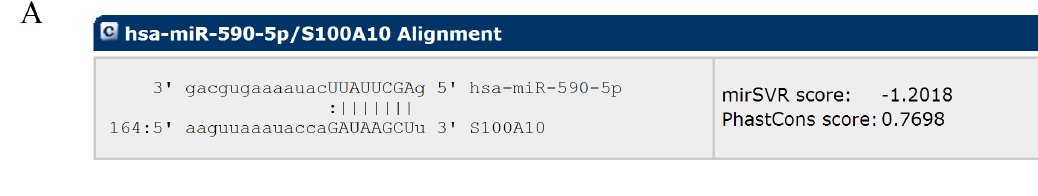
Figure 1. Bioinformatic analysis on the sequences of miR-590-5P and 3'-UTR of S100A10 and expression levels of miR-590-5P and S100A10 in human hepatocarcinoma cell lines and a normal liver cell line. ( A ) Alignment between miR-590-5p and S100A10 from microRNA.org (Targets and Expression); ( B ) Total RNA was extracted from the cells, and reversely transcribed and analyzed by quantitative PCR, and the expression level of miR-590-5P was normalized with internal control U6. The results are given as mean ± SD of three independent experiments; ( C ) Cell lysates of the indicated cells were prepared, and S100A10 levels were determined by specific primary antibody against S100A10 followed by HRP-linked secondary antibody. The bands were visualized by enhanced a chemiluminescence detection system. One representative of three independent experiments is